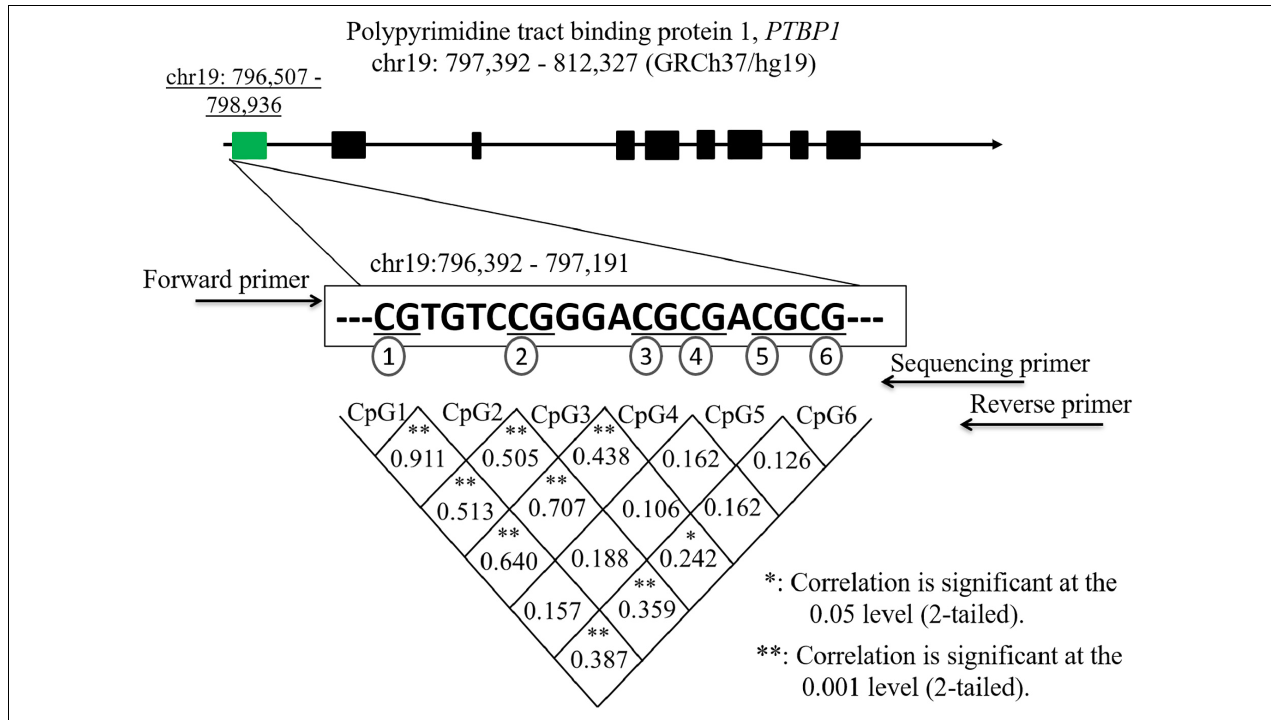
FIGURE 1 | Correlations among six CpG sites in the PTBP1 gene. * p < 0.05, ** p < 0.001.